Question: Give a one-sentence summary of this figure.
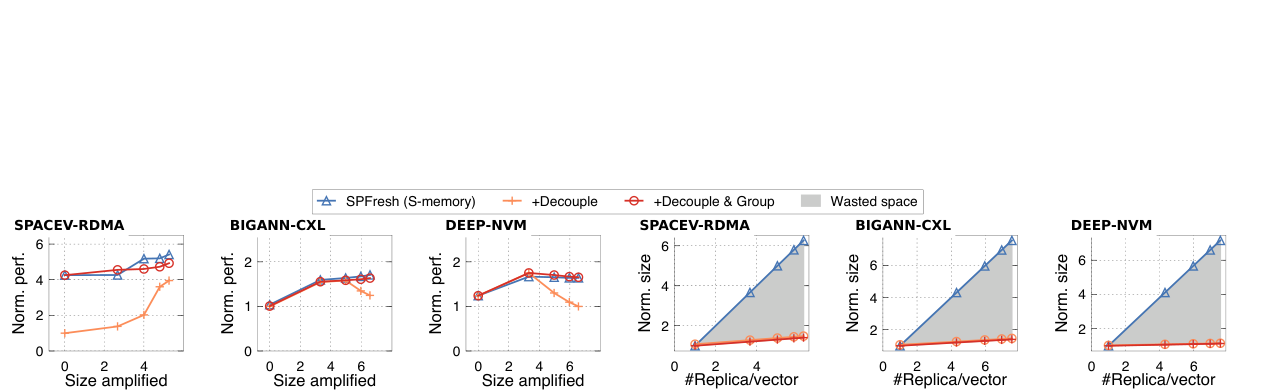
Answer: Effects of cluster-aware grouping (a)–(c) and decoupled layout (d)–(f) on graph index. Due to space limitation, we only list a subset of the overall results. The trends for the others are similar.